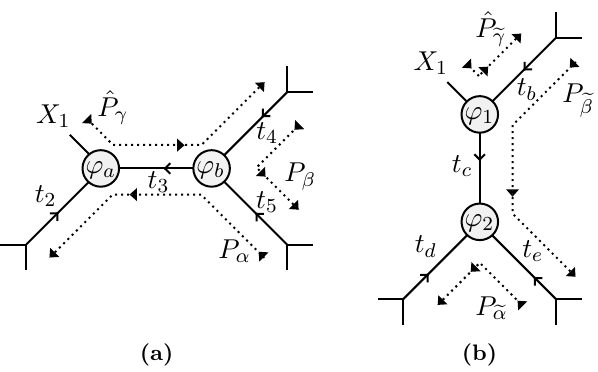
Figure 16. Two dual sub-graphs of a target graph with an external edge in common.